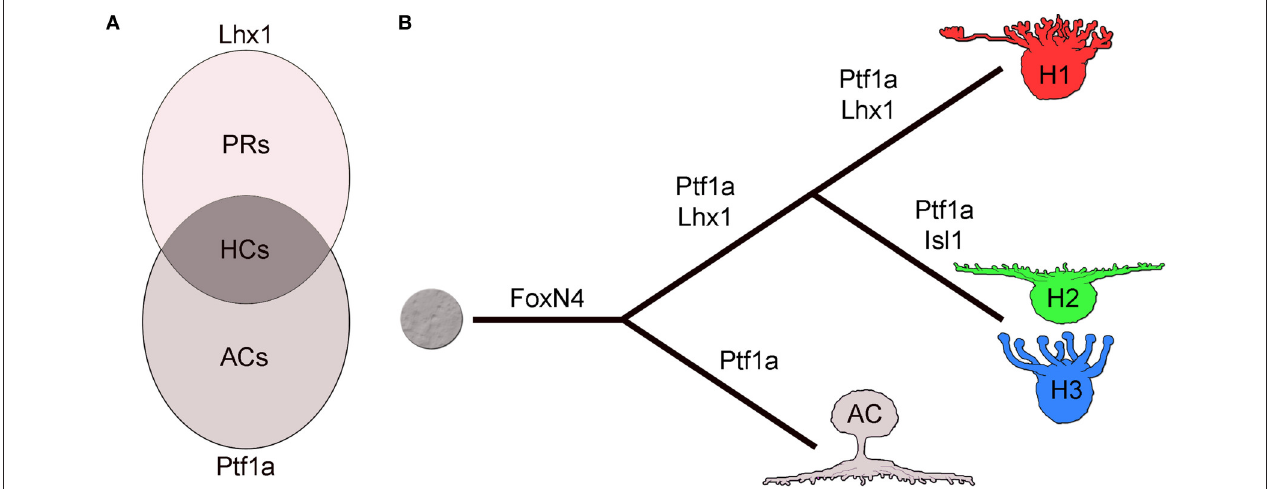
FIGURE 2 | Horizontal cell fate and cell type formation. (A) Horizontal cell fate assignment can be regarded as the intersectional population of the independent expression of Ptf1a and Lhx1. (B) The pathway to horizontal cells is linked to amacrine cells by the expression of FoxN4 and Ptf1a while Lhx1 separates the HC lineage from ACs. Isl1 blocks Lhx1 expression to form the axon-less subtypes. AC; amacrine cell, HC; horizontal cell, H1-3; horizontal cell type 1-3, PR; photoreceptor.